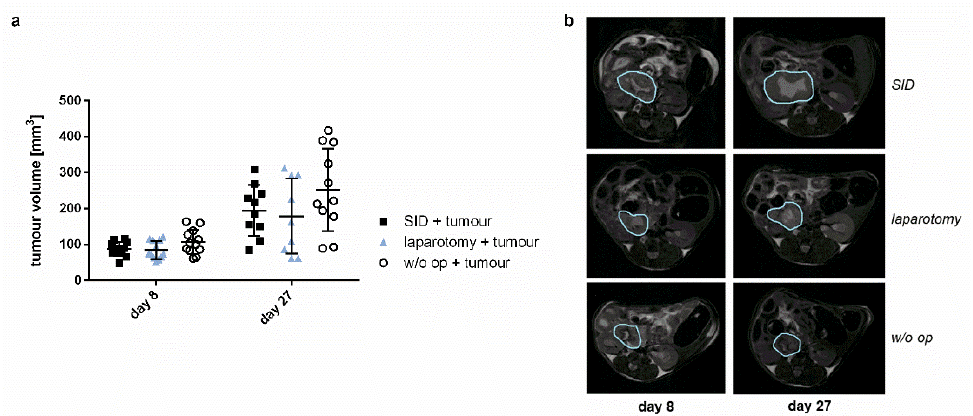
Figure 4. Tumour volume. Tumour volume was measured with MRI 8 days and 27 days after tumour implantation. There was no significant difference in the tumour growth between the operation groups. ( a ) Tumour volume 8 and 27 days after tumour implantation in mm 3 . Values represent mean and standard error; n = 9–12 (day 8: n = 12 for all groups; day 27: SID + tumour: n = 10, laparotomy + tumour: 9, w/o op + tumour: 11); ( b ) Representative MRI pictures of the tumour.